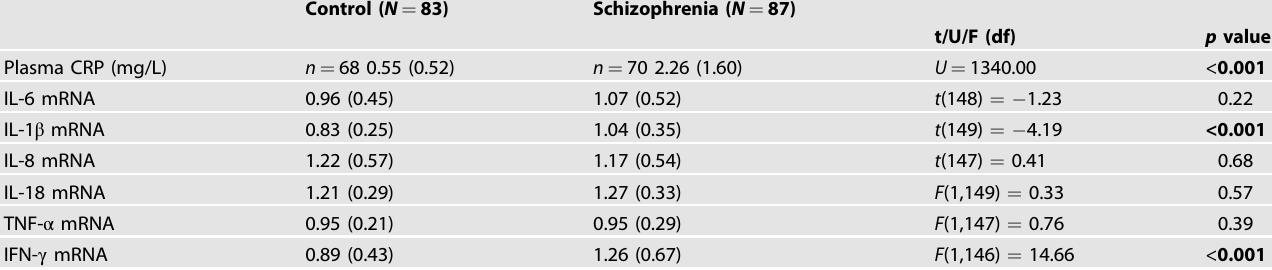
Table 2. Comparison of plasma CRP and proin fl ammatory cytokine mRNA levels between diagnostic